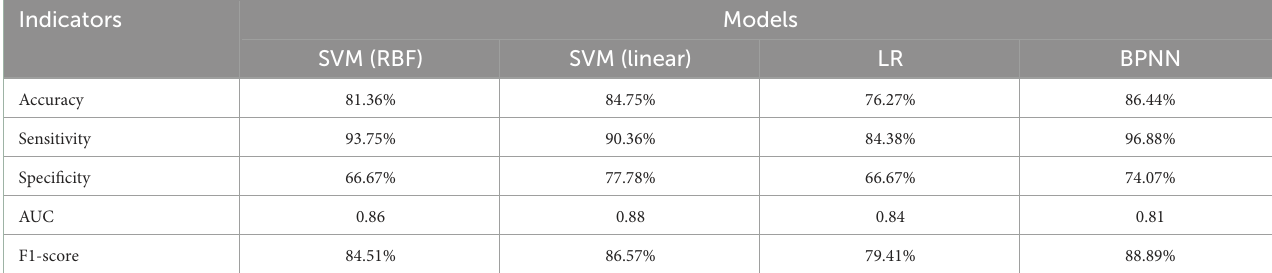
TABLE 3 The evaluation indicators of SVM (linear), SVM (RBF), BPNN and LR.